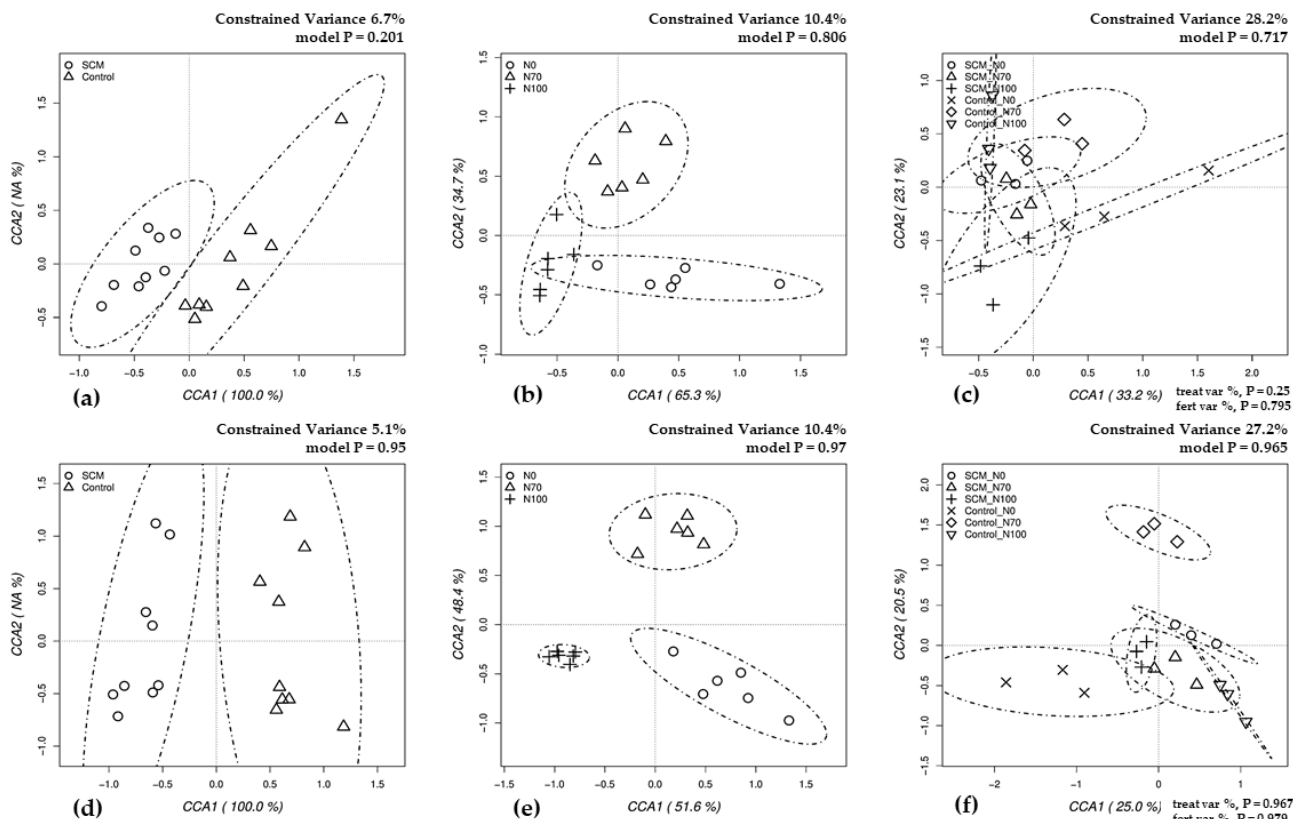
Figure 4. Canonical correspondence analyses (CCAs) on the impact of the treatments on the structure of bacterial ( a – c ) and fungal ( d – f ) communities. Determined by the relative abundances of all the operational taxonomic units OTUs obtained by Illumina sequencing of bacterial 16S and fungal ITS amplicons. Control_N0 = Control with 0% N-fertilization; Control_N70 = Control with 70% N-fertilization; Control_N100 = Control with 100% N-fertilization; SCM_N0 = SCM with 0% N-fertilization; SCM_N70 = SCM with 70% N-fertilization; SCM_ N100 = SCM with 100%